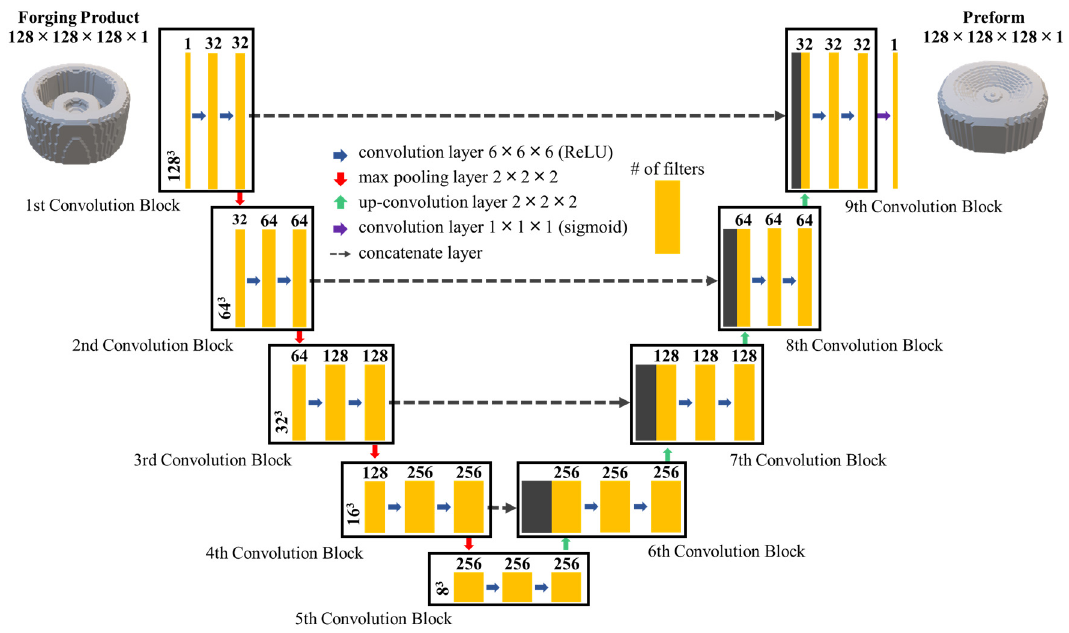
Figure 2. CNN model overall structure.